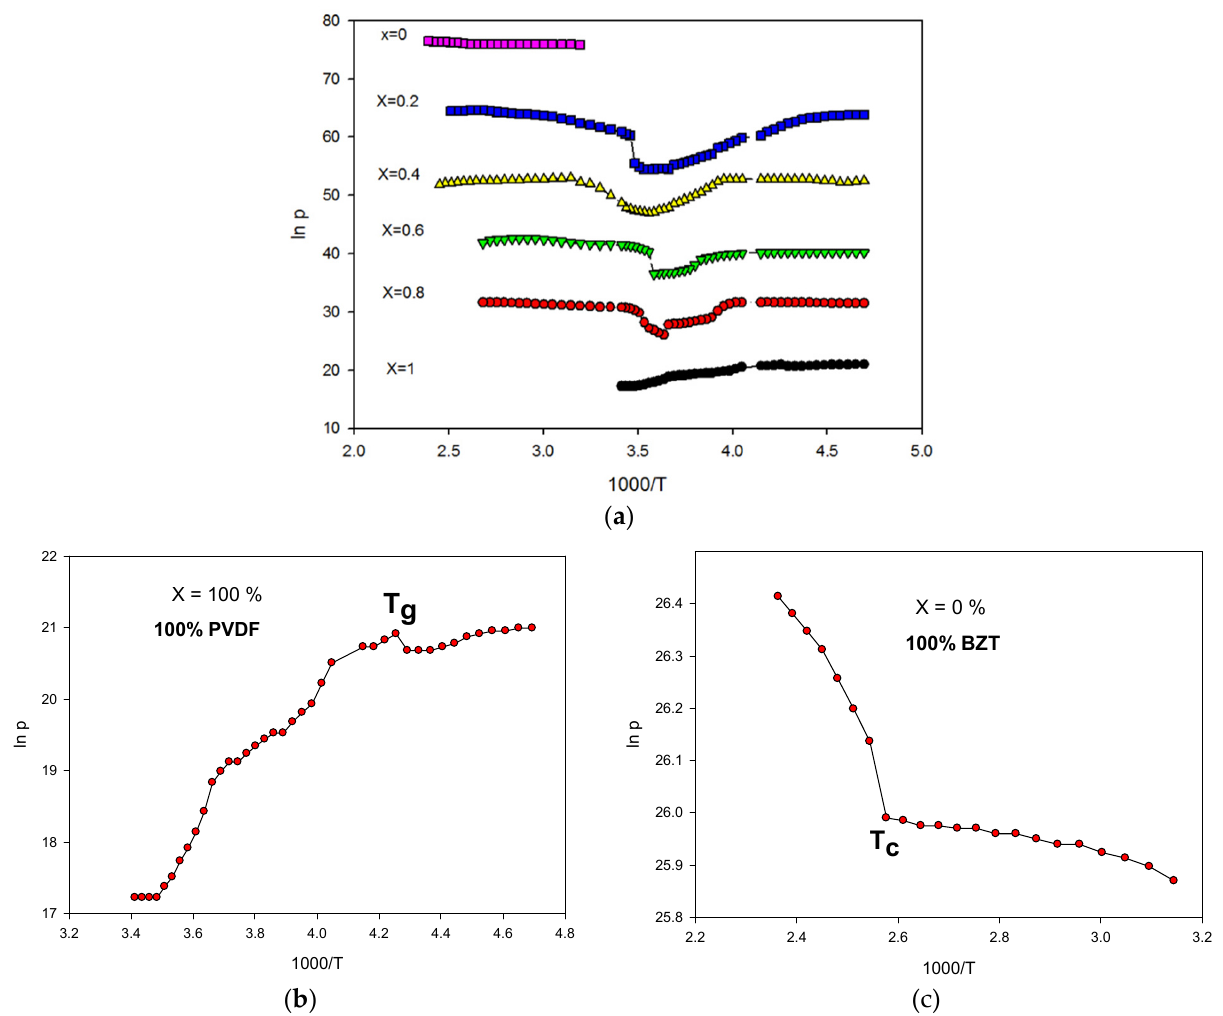
Figure 4. ( a ): The DC resistivity as a function of 1000/T of (BZT-PVDF) composite. ( b , c ) The DC resistivity as function of 1000/T of (BZT-PVDF) composite at x = 0 and 1. Table 1. Values of activation energy of (BZT-PVDF) composite.